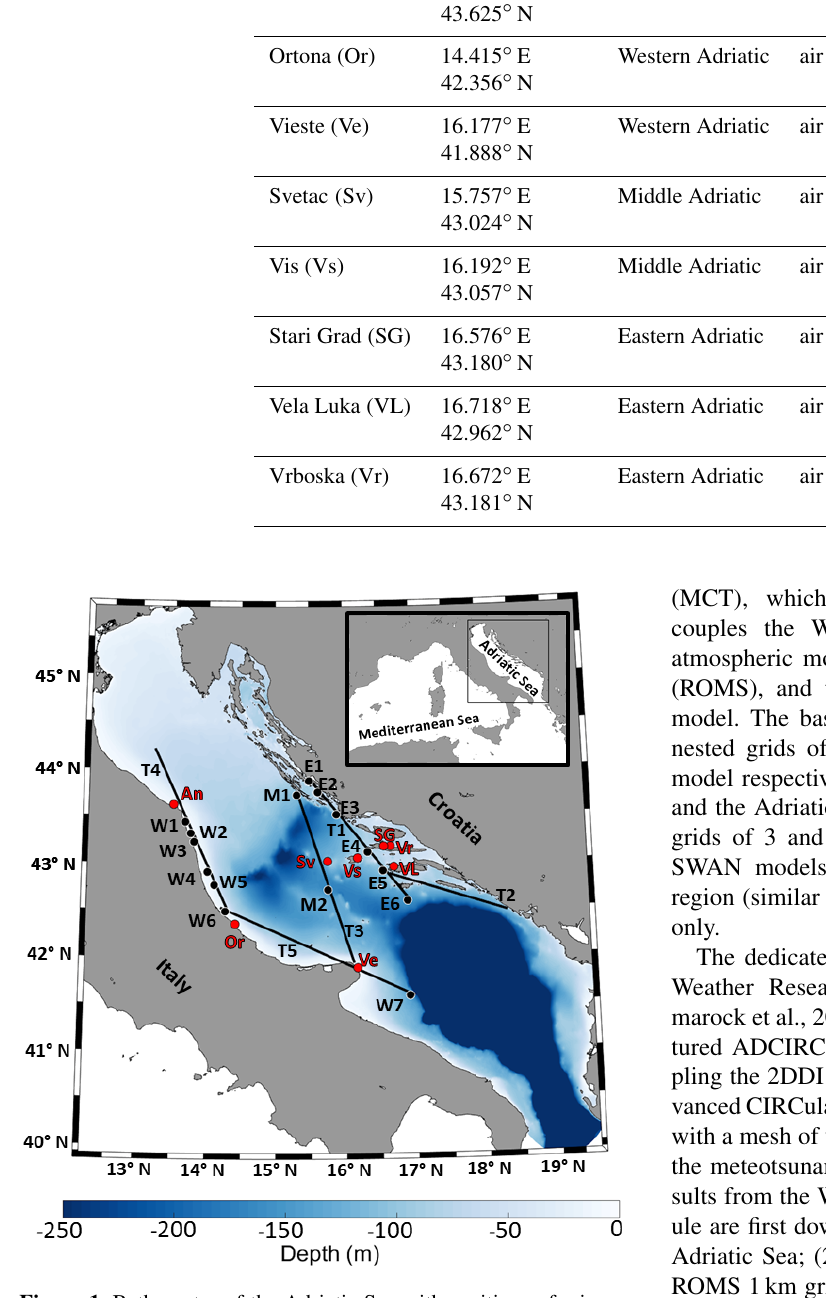
Figure 1. Bathymetry of the Adriatic Sea with positions of micro- barographs and tide gauges (red circles). Black circles denote model grid points along transects T1 to T5 (black lines) on which the high- est energy is reproduced within selected meteotsunami energy ban- ners in the eastern (E1 to E6), middle (M1 and M2), and western (W1 to W7)